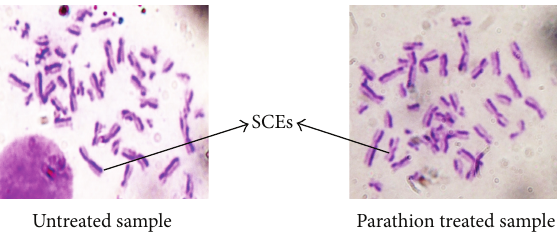
Figure 1: SCEs shown in untreated and parathion treated sample.